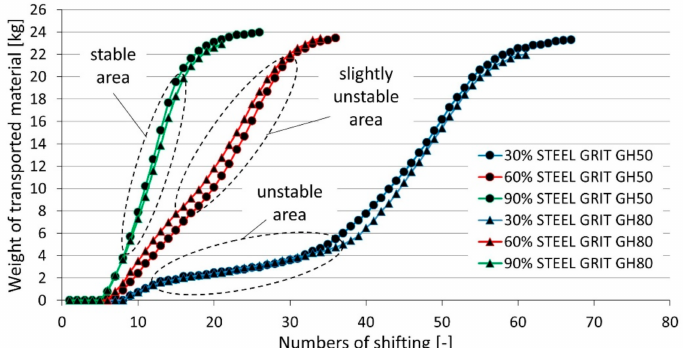
Figure 10. Dependence of real weight of the transported materials, STEEL GRIT GH50 and GH80, on number of the strokes during gradual feeding with 25 kg of this material at the 30%, 60% and 90% levels of the shifting